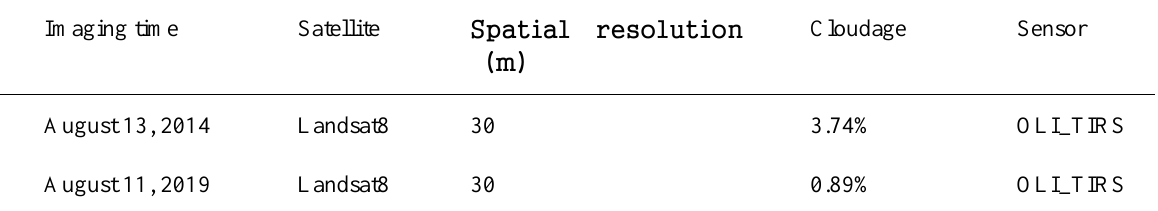
Table 1. Satellite data